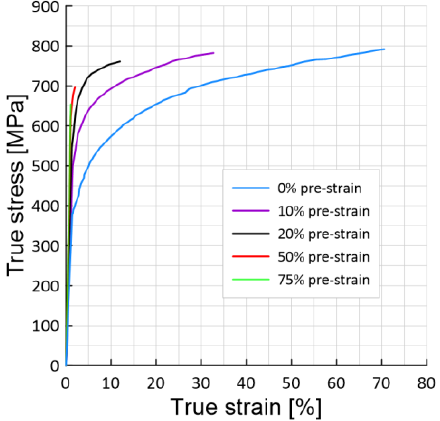
Figure 6. Stress-strain curves for hydrogen-charged samples for 48 h.